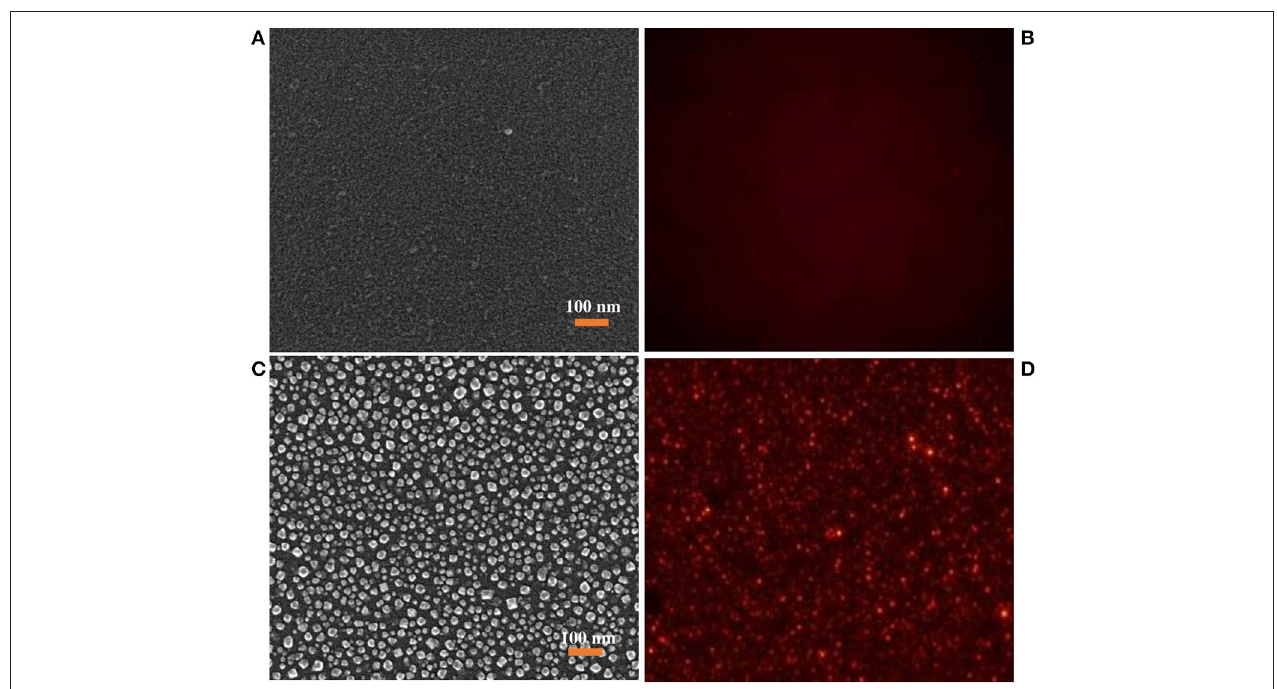
FIGURE 2 | (A) SEM images of immobilized PDA liposome in film structure, (B) corresponding fluorescence images of Immobilized PDA liposome in film structure obtained after heating treatment, (C) SEM images of immobilized PDA liposome in vesicle structure, (D) corresponding fluorescence images of Immobilized PDA liposome in vesicle structure obtained after heating treatment.